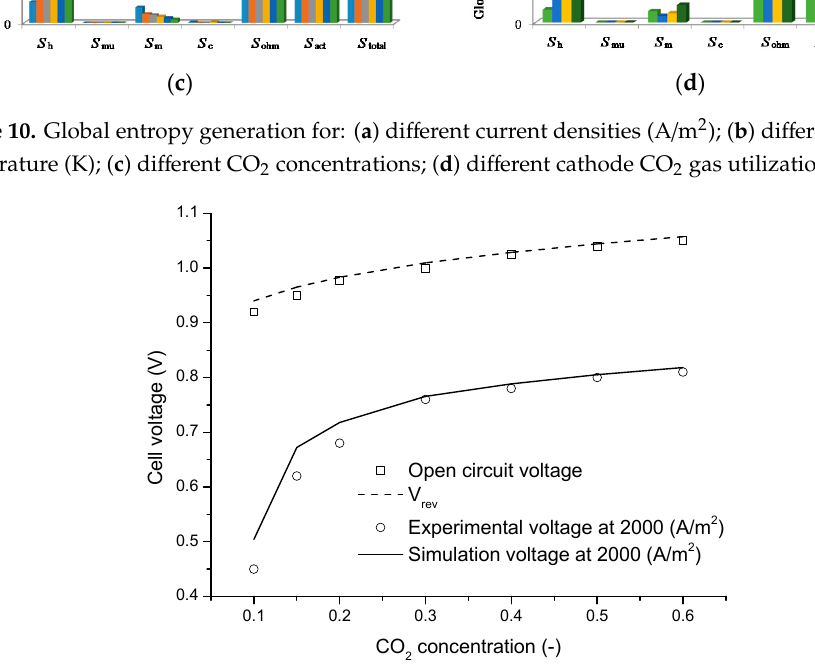
Figure 11. Experimental voltage and simulation voltage for di ff erent concentrations of CO 2